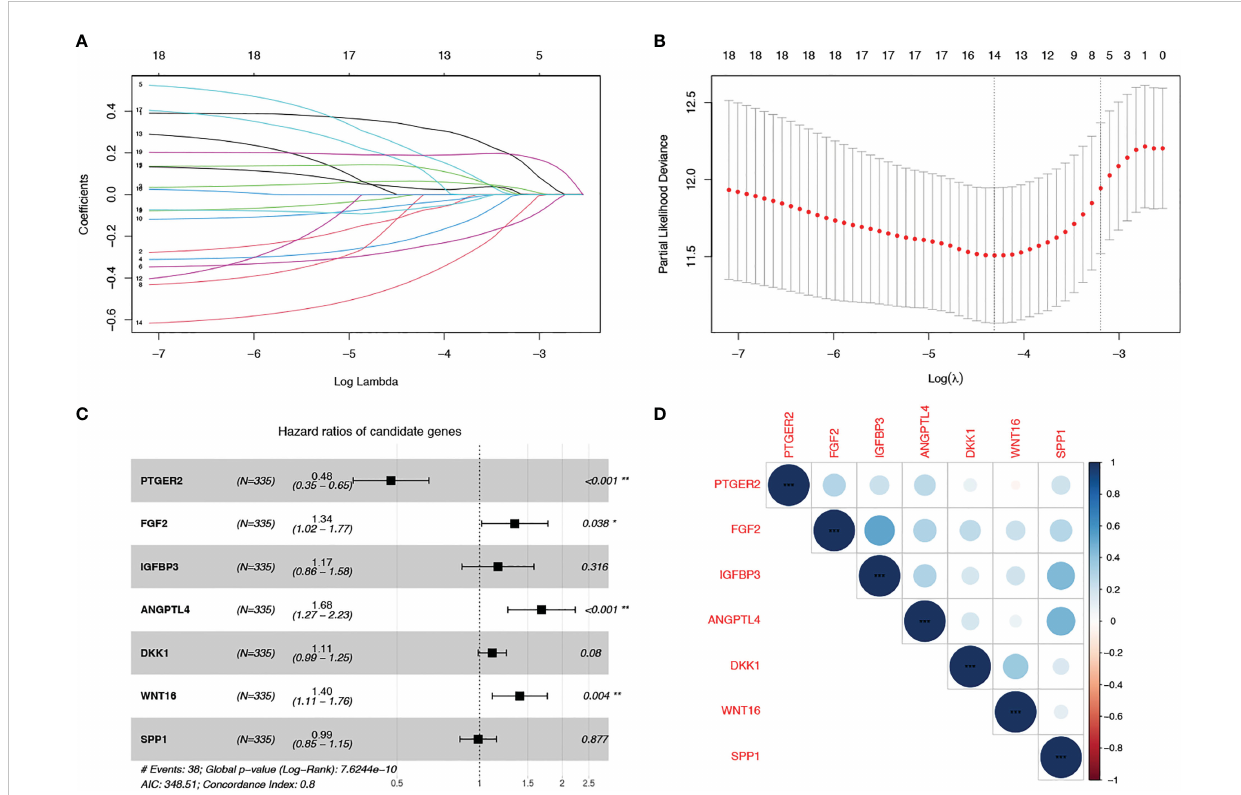
FIGURE 1 Construction of a cell senescence-associated prognostic model based on the SenMayo gene set. (A, B) LASSO Cox regression analysis was conducted to screen the key genes; (C) Forest plots showing the results of the univariate Cox regression analysis between overlapping genes and overall survival; (D) Correlation of the seven model gene